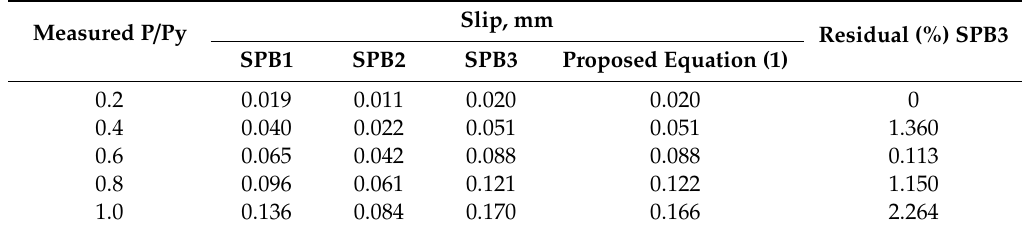
Table 4. Comparison of slip between the test results of SPBs and the proposed equation.